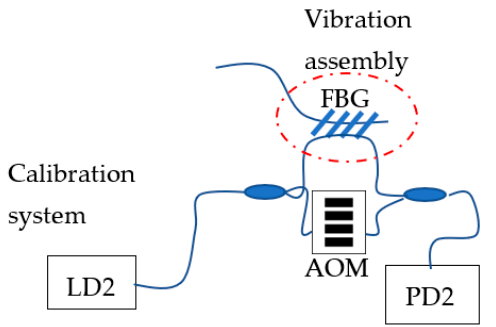
Figure 9. Vibration assembly for the calibration system and FBG sensor. LD2, laser diode of the calibration interferometer; PD2, photodetector; AOM, acousto-optic modulator.